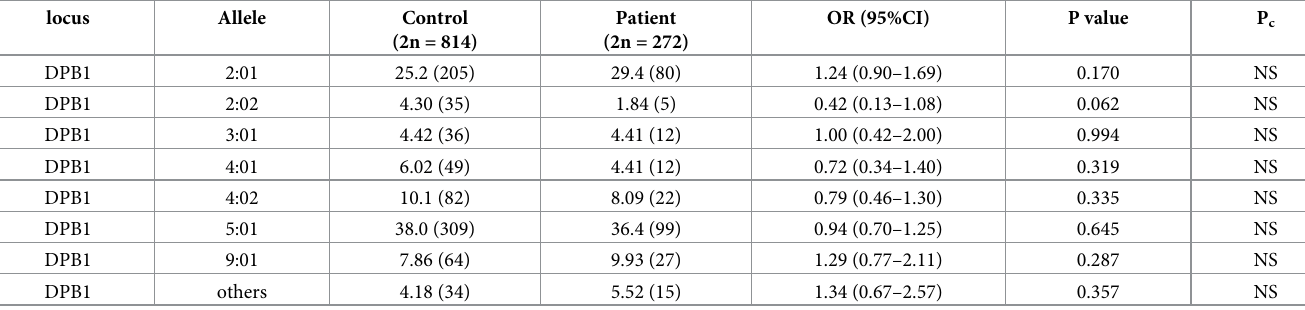
Table 3. Frequencies of HLA-DPB1 allele carrier in MMD patients and